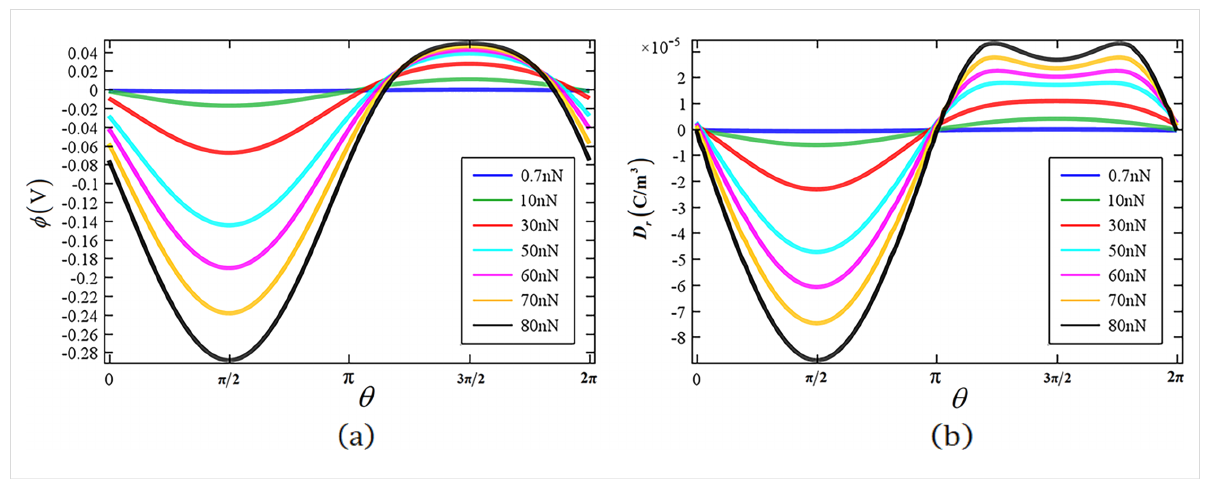
Figure 7: (a) Boundary electric potential and (b) boundary electric displacement D r at Ω for different end forces P = 0.7, 10, 30, 50, 60, 70 and 80 nN.